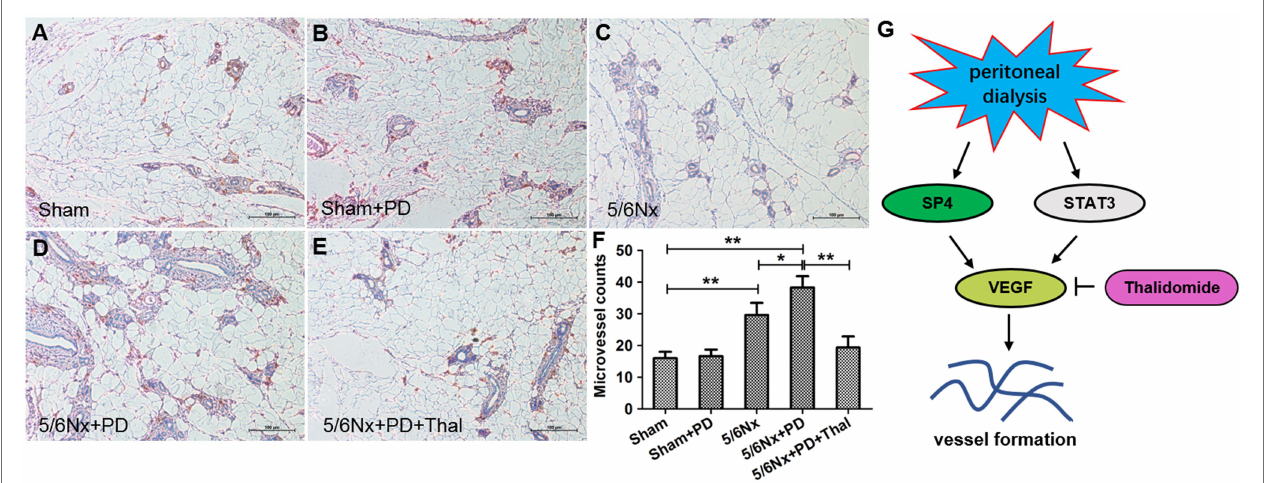
FIGURE 5 | Thalidomide reduced microvessel density in 5/6Nx + PD model rats. Microvessel density (marker: CD34) was determined by IHC assay in the peritoneum of rats. (A) sham rats, (B) sham+PD, (C) 5/6Nx rats, (D) 5/6Nx + PD rats, and (E) 5/6Nx + PD rats were intraperitoneally administered thalidomide. (F) Quantitative analysis of the microvessel counts to calculate the microvascular density. (G) Proposed scheme for the mechanism by which thalidomide obstructs vessel formation in vivo and in vitro . Each of the four groups contained seven rats ( n = 7). Bars = 100 μ m. * p < 0.05; ** p <